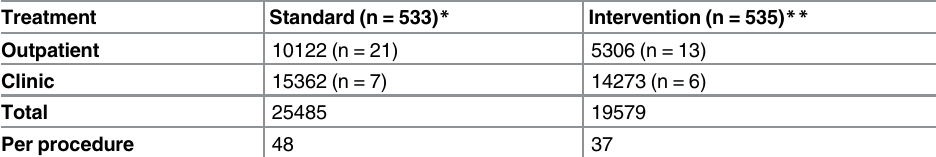
Table 2. Cost of complications 2011 EUR.